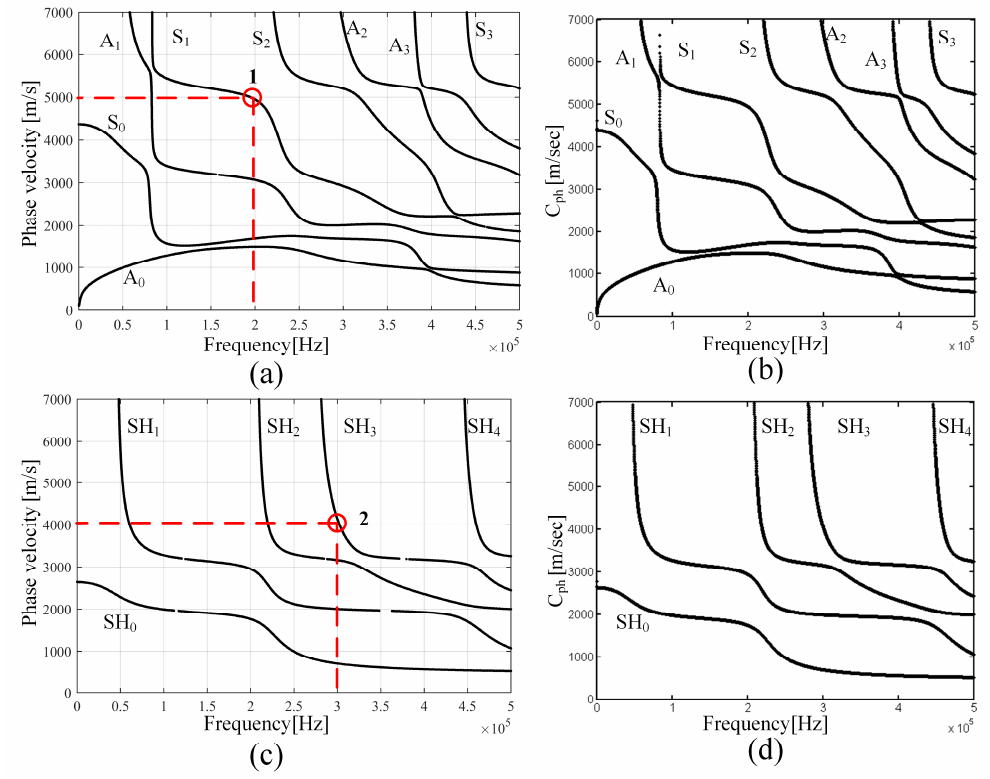
Figure 2. Dispersion curves of, ( a ) Lamb waves using GMM; ( b ) Lamb waves using SAFE; ( c ) SH waves using GMM; and ( d ) SH waves using SAFE.